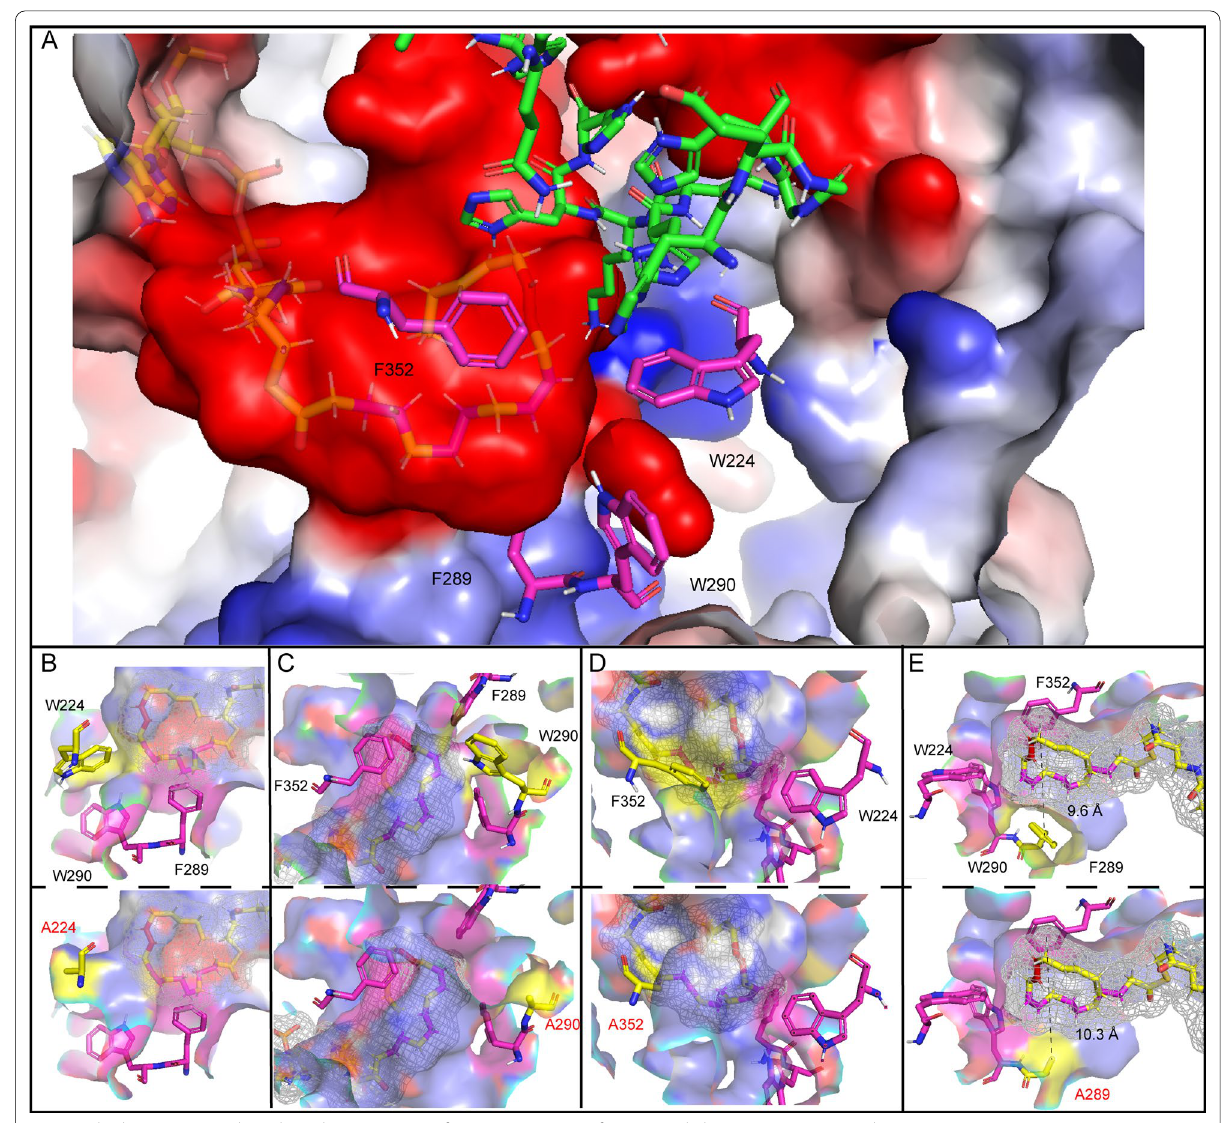
Fig. 5 The key amino acids in the substrate cavity of Mp FADS6 ( A ). Conformational changes in Mp FADS6 due to mutations W224 ( B ), W290 ( C ), F352A ( D ), and F289A ( E ). The yellow stick indicates the mesh of substrate ALA-CoA. The red atom represents the position of the double bond induced by FADS6. The magenta atom represents the double bond at C15 of